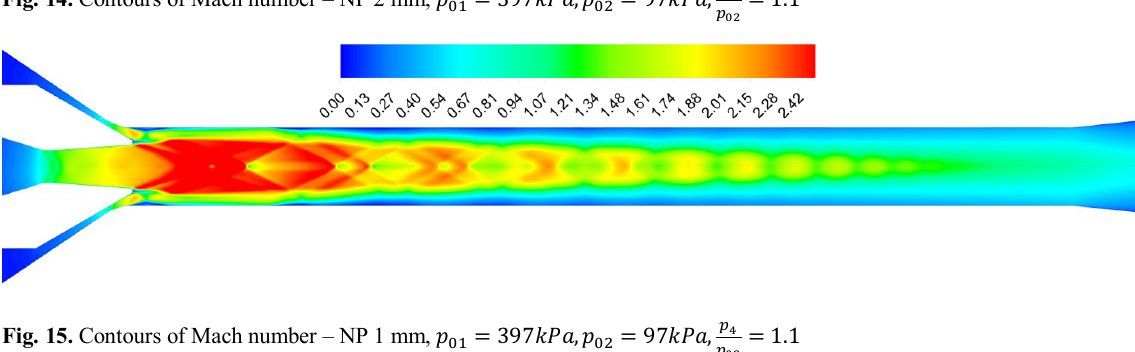
Fig. 14. Contours of Mach number – NP 2 mm, 𝑝